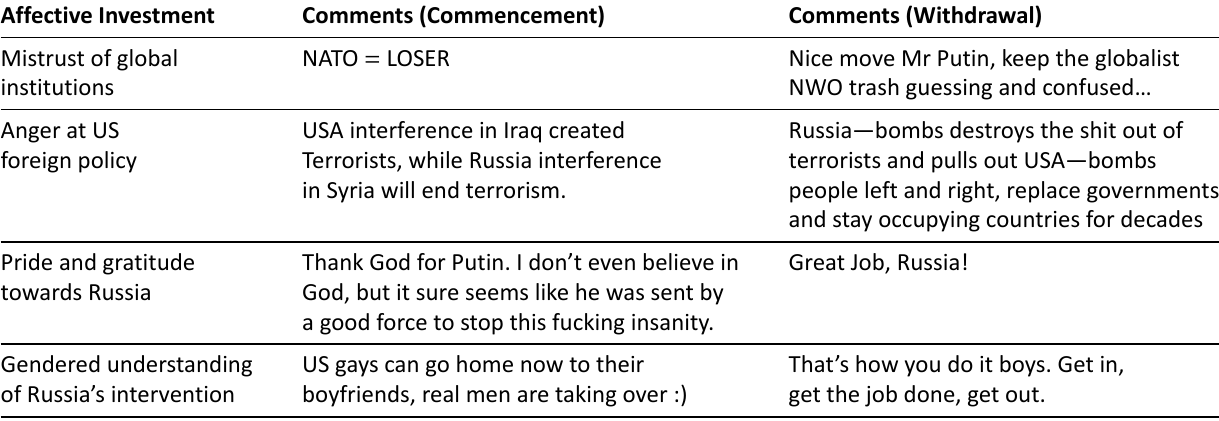
Table 4. Examples of audience comments displaying affective investments in Russian military force in Syria. Affective